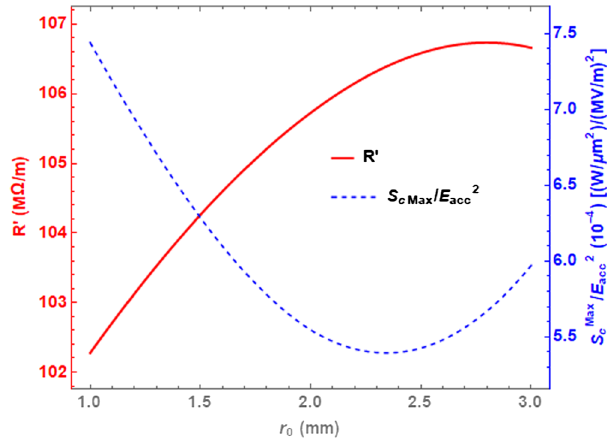
FIG. 1. The general geometry of the cell design with parameters labeled. The electron beam travels from left to right along the z -axis, i.e. r ¼ 0